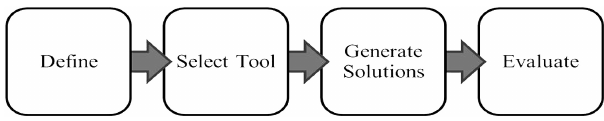
Figure 1. Four-step systematic creativity process according